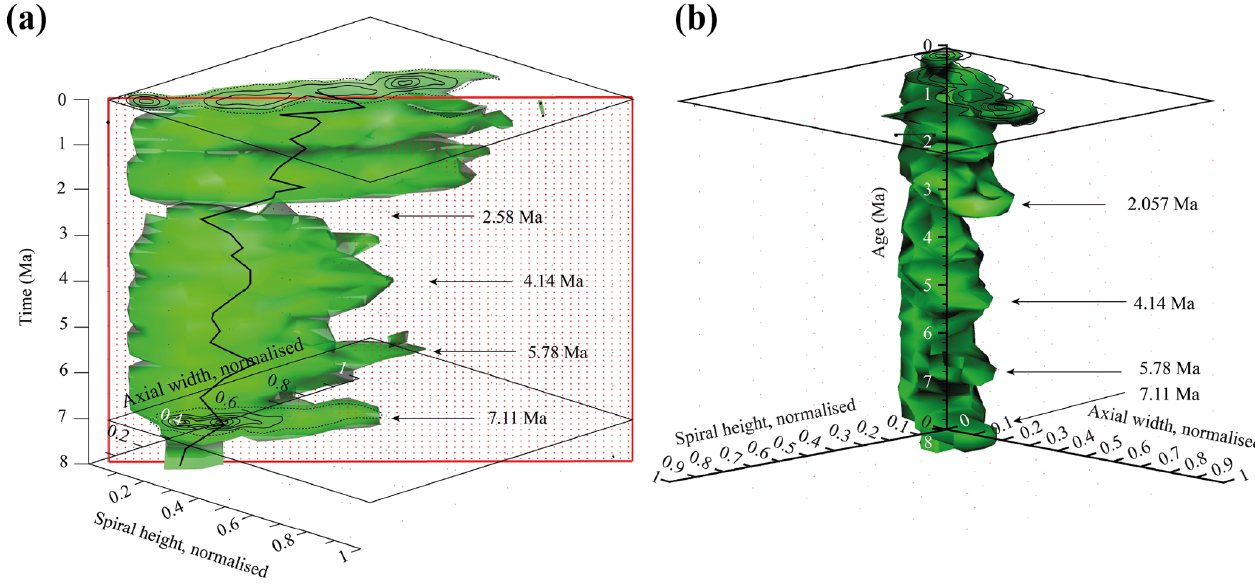
Figure 9. Volume density diagrams (VDD) of the normalised spiral height ( δX ) versus the normalised axial width ( δY ) over the past 8Myr for G. menardii at the eastern tropical Atlantic Hole 667A. The shown iso-surface has a value of 0.89447168, which equals the frequency of one specimen. Thus, it represents rare, innovative specimens. (a) VDD in side view. The red, dotted plain represents the section shown in Fig. 10. The CFDs of the samples from 0.003 and 7.11Ma are displayed. The black line represents the mean values. (b) VDD in front view. The CFD of the sample from 0.003Ma is displayed as an example. The arrows at 7.11, 5.78 and 4.14Ma point to size peaks, and the arrow at 2.58Ma marks the sample with the smallest observed test size. The settings for the VDD construction are given in the Supplement (file